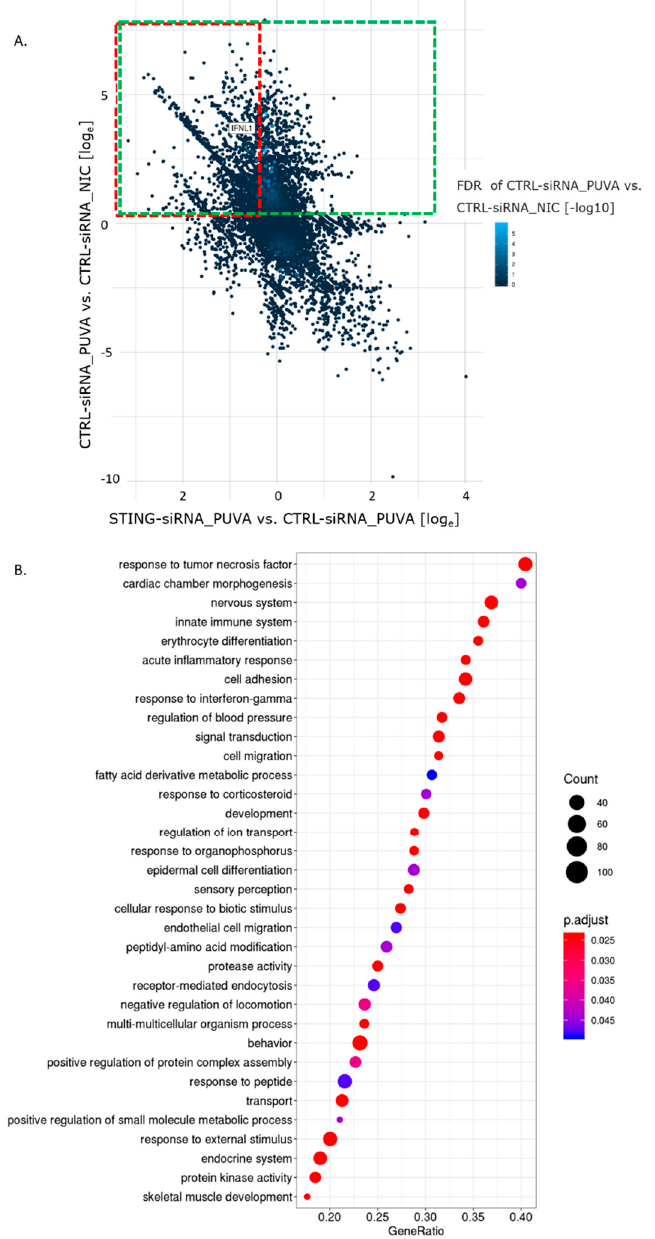
Figure 4. Unbiased analysis of the transcriptional response in Hut78 to 8–MOP + UVA treatment, performed by RNA-Seq. ( A ) 2D dot plot showing genes affected by 8–MOP + UVA treatment and STING downregulation. X -axis: gene expression ratio between STING-siRNA and CTRL-siRNA- transfected samples after 8–MOP + UVA (PUVA) treatment. Y -axis: gene expression ratio between NIC and 8–MOP + UVA samples, transfected with CTRL-siRNA; green frame: transcripts upregulated after 8–MOP + UVA treatment by at least 1 on the log e scale; red frame: transcripts upregulated by 8–MOP + UVA, which upregulation was suppressed by STING knockdown. Dot color scale: − log10 value of the false discovery rate (FDR) significance score of the differential expression (DE) analysis between the CTRL-siRNA_PUVA and CTRL–siRNA_NIC conditions. ( B ) Set of gene ontology (GO) pathways showing a significant change between NIC and 8–MOP + UVA (PUVA)-treated samples, transfected with CTRL-siRNA. They were sorted based on the gene ratio, which is the number of genes related to the GO term/total number of genes of interest. The complete list of pathways was summarized into broader categories shown in the Y -axis. The gene number ratio is shown in the X - axis, and adjusted p -values and counts are shown with a color scale and dot size.